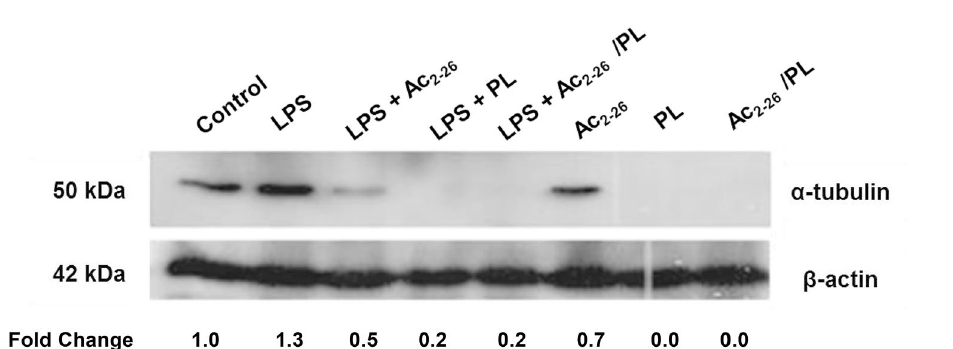
Figure 5. PL inhibits α-tubulin expression. Western blotting analysis of HUVECs treated with PL alone or in combination with Ac 2-26 and/or LPS shows that PL inhibits α-tubulin (50 kDa) expression. β-actin (42 kDa) was used as an endogenous control. No LPS/PL/Ac 2-26 was added to the negative control. Fold change relative to control was calculated using the α-tubulin: β-actin ratio. Reproduced with permission from 96 . The vertical streaks on the blot images were probably caused by a contaminant on the scanning lamp/lens assembly